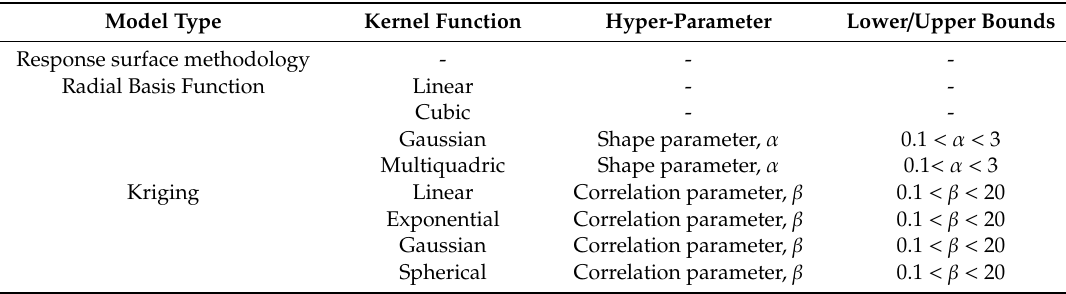
Table 4. Parameters of surrogate model candidates.